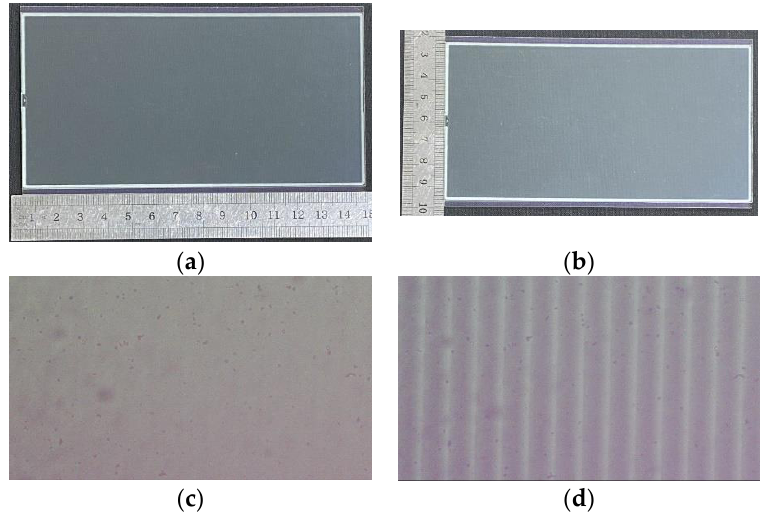
Figure 6. Fabricated cylindrical LC lens array with size of ( a ) length 140 mm, ( b ) width 70 mm, and the focusing effect of the cylindrical LC lens array with ( c ) 0 V and ( d ) 5.4 V operating voltages.